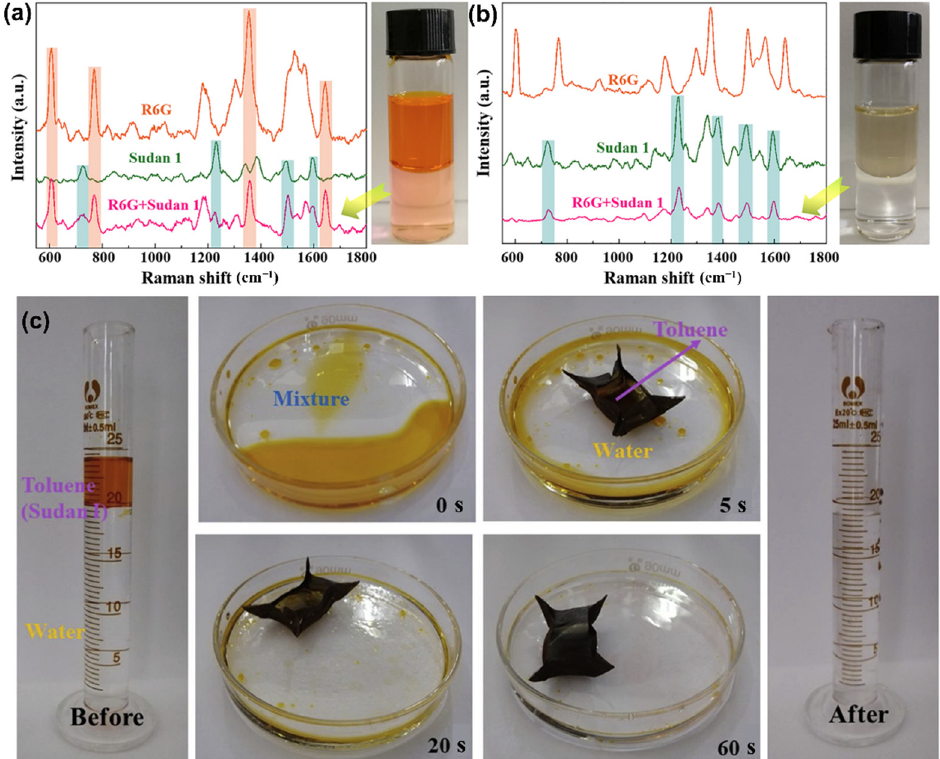
Figure 7. ( a ) The SERS spectra of Rh6G aqueous solution (10 − 5 M), Sudan 1 toluene solution (10 − 3 M) and their mixture detected from PSi/MoS 2 MSC. ( b ) The SERS spectra of Rh6G aqueous solution (10 − 9 M), Sudan 1 toluene solution (10 − 5 M), and their mixture detected from PSi/MoS 2 /Au MSC [95]. ( c ) Extract toluene from the mixed ”water/toluene” solution by hydrophobic Cu/CuO @Ag substrate. Reprinted with permission from ref. [96]. Copyright 2020 Elsevier.